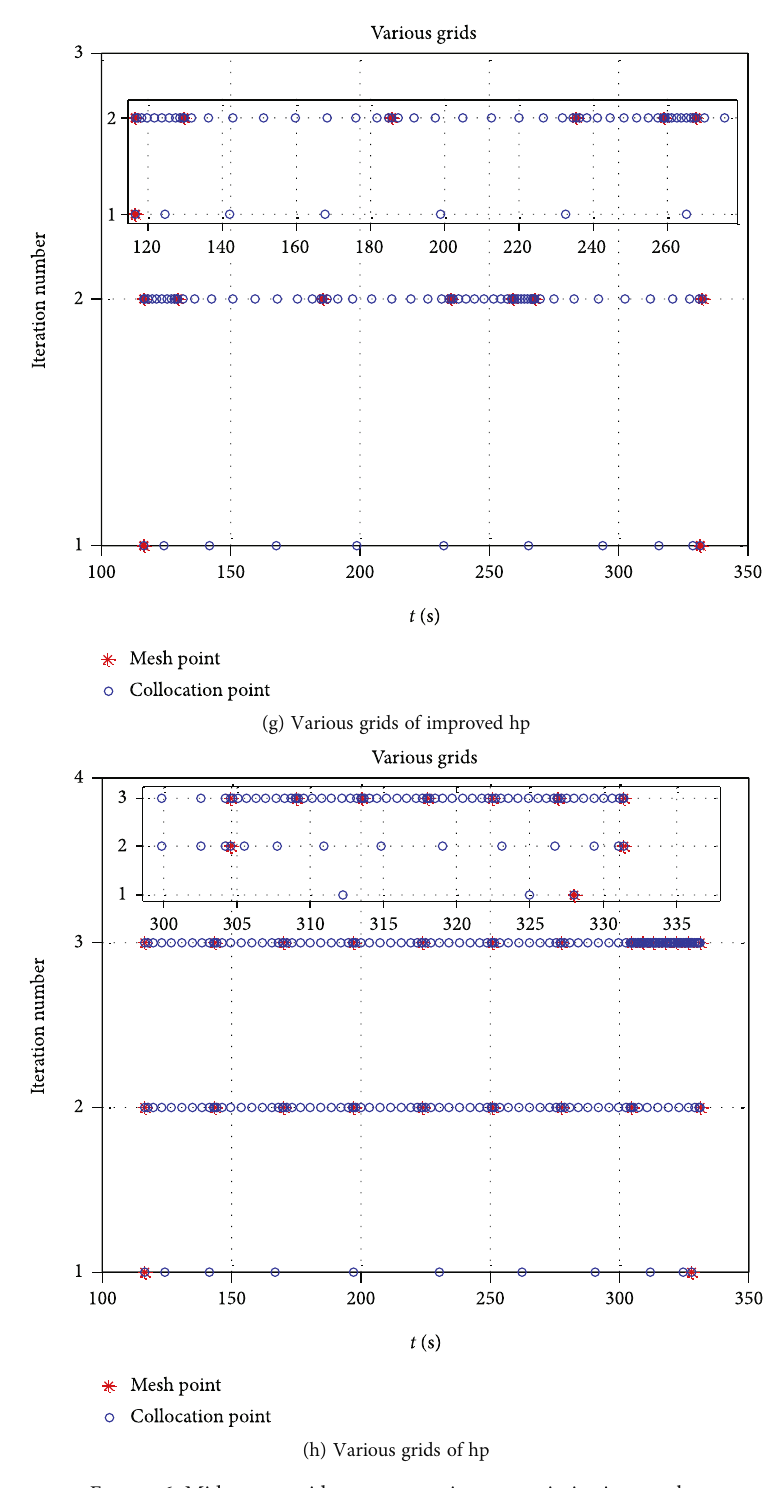
Figure 6: Midcourse guidance stage trajectory optimization